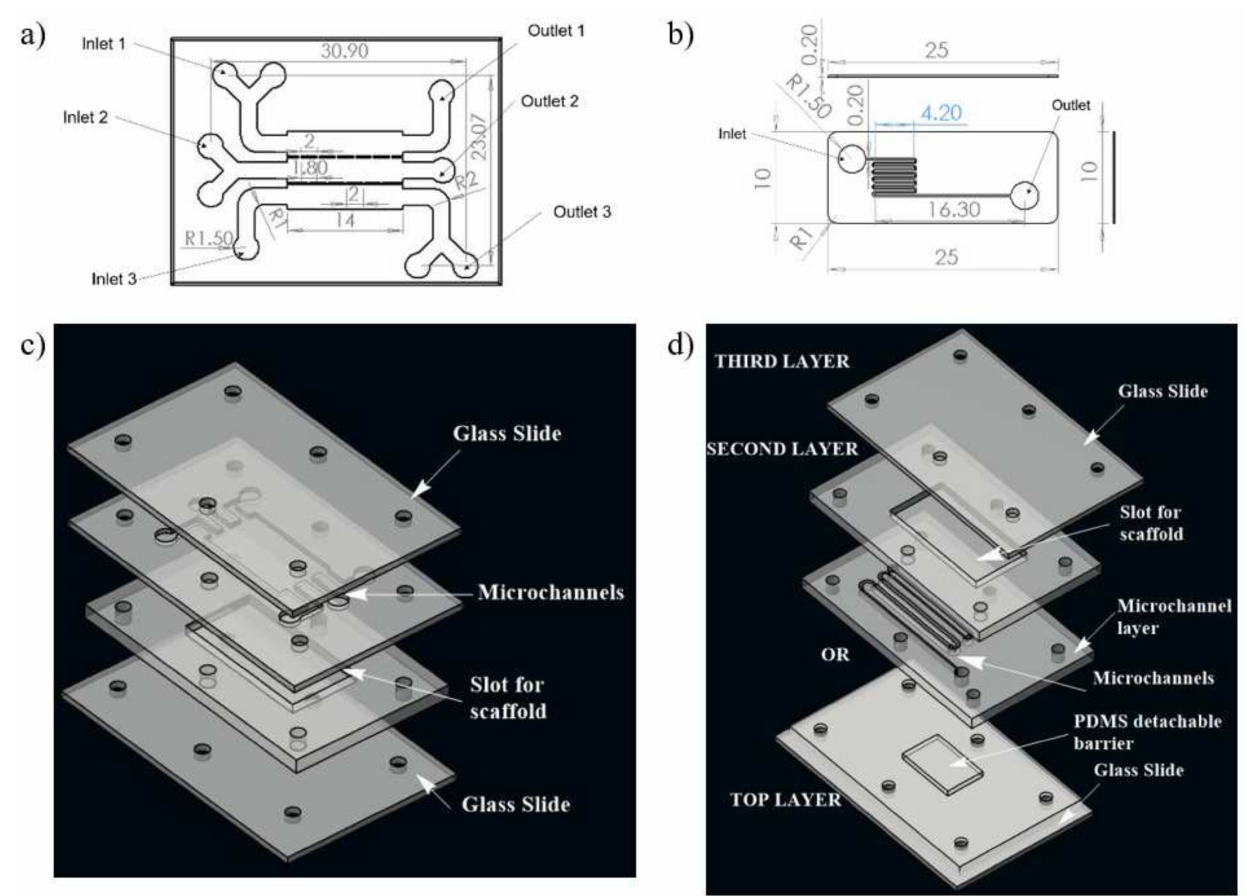
Figure 1. Schematic illustration of the two designs of microchannel of microfluidic chip used for the study; ( a ) design 1 with three inlet and outlet, ( b ) design 2 with one inlet and one outlet for fluid flow, ( c ) 3D view of design 1, ( d ) 3D view of complete chip of design 2. The media was injected through the inlet. In case of design 1, wound is made through flow of trypsin enzyme, whereas in design 2, the wound is created due to presence of PDMS